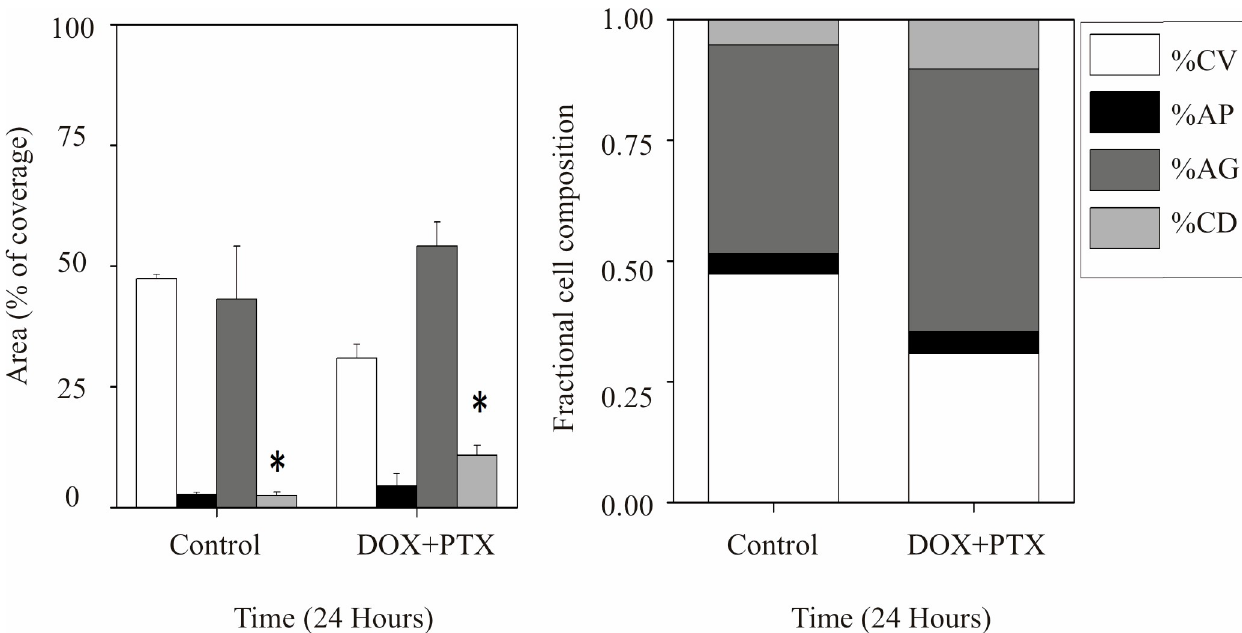
Fig 5. Doxorubicin combined with Paclitaxel. Bar graph denotes the effect of PTX after 24 hours on cells death modes. Propidium staining ( CD ) increased significantly with respect to the control. The area covered by live cells ( CV ) showed a decrease which was not significant in comparison to the control. Right stacked bar graph shows the value of the results in cell fraction composition after 4-hour exposure to doxorubicin and a combination of paclitaxel and doxorubicin per day. ( � ) Indicates significant difference with days among subgroups (p < 0.05).